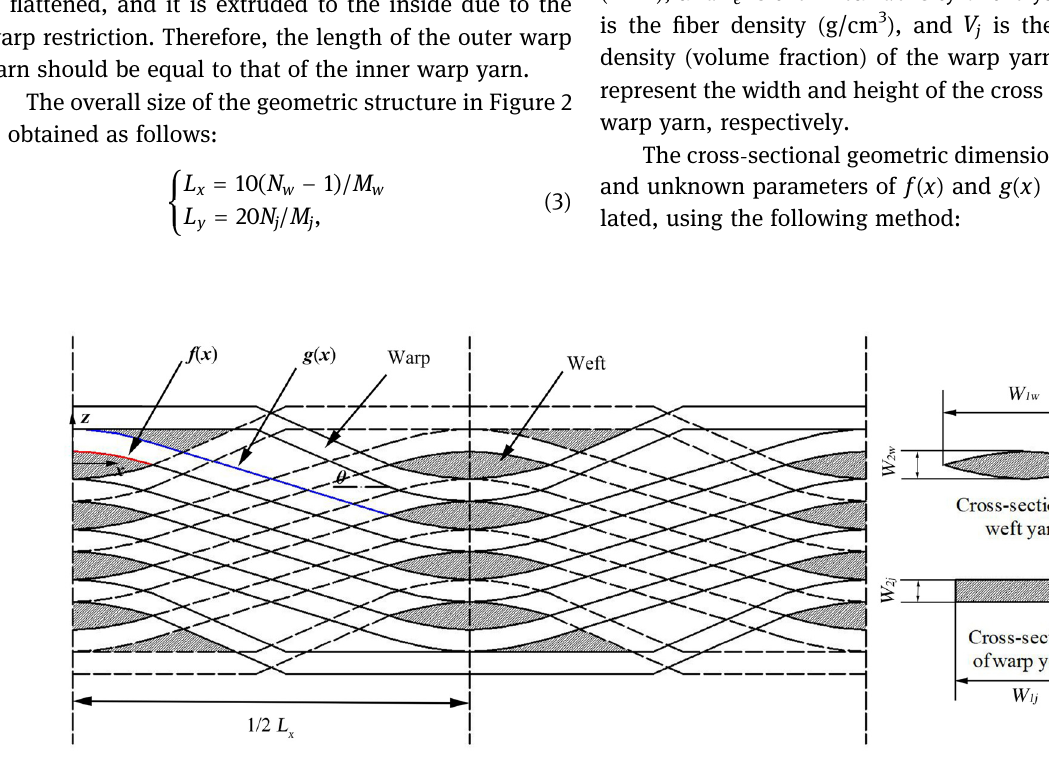
Figure 2: Geometric structure of 2.5D woven composites.